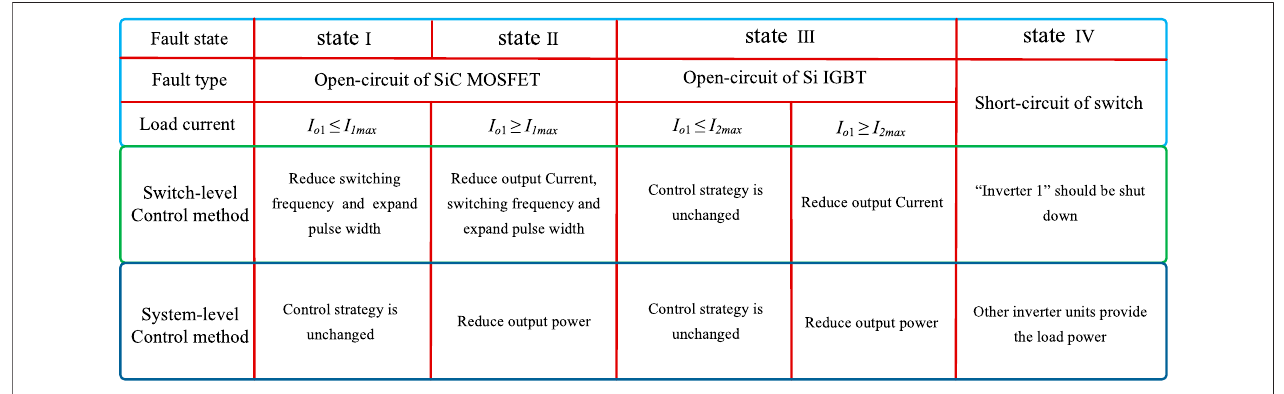
FIGURE 6 | Classi fi cation of redundant management strategies.